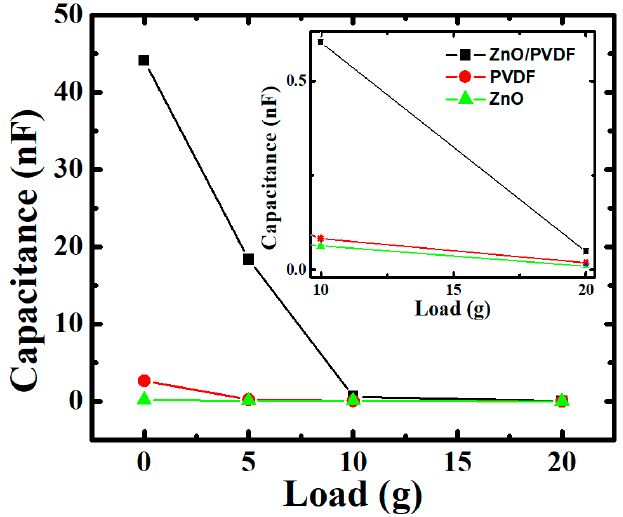
Figure 7. Comparison of capacitance change among three samples: ZnO, PVDF, and ZnO/PVDF with piezoelectric layers between PDMS:Carbon black electrodes, with varying load.